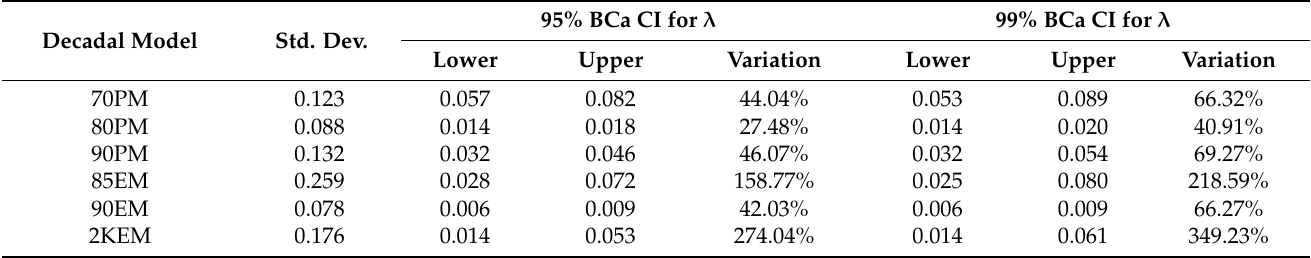
Table A2. The BCa confidence intervals of λ for each decadal model in Peninsular Malaysia and East Malaysia for the conventional SCS-CN